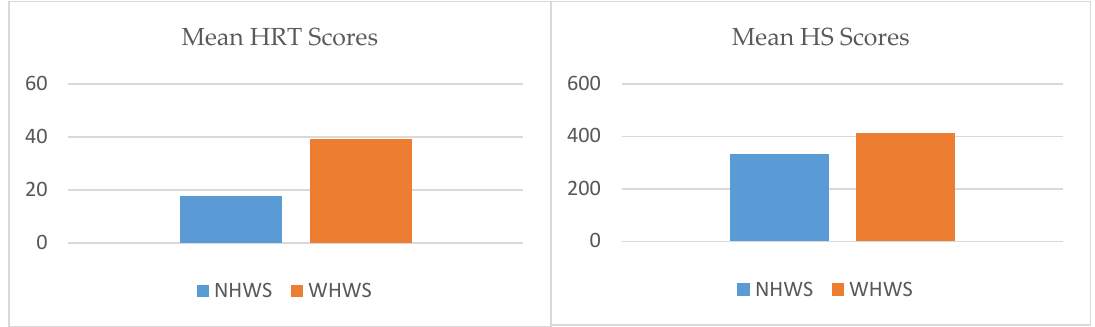
Figure 3. Mean HRT and HS scores of NHWS and WHWS groups.